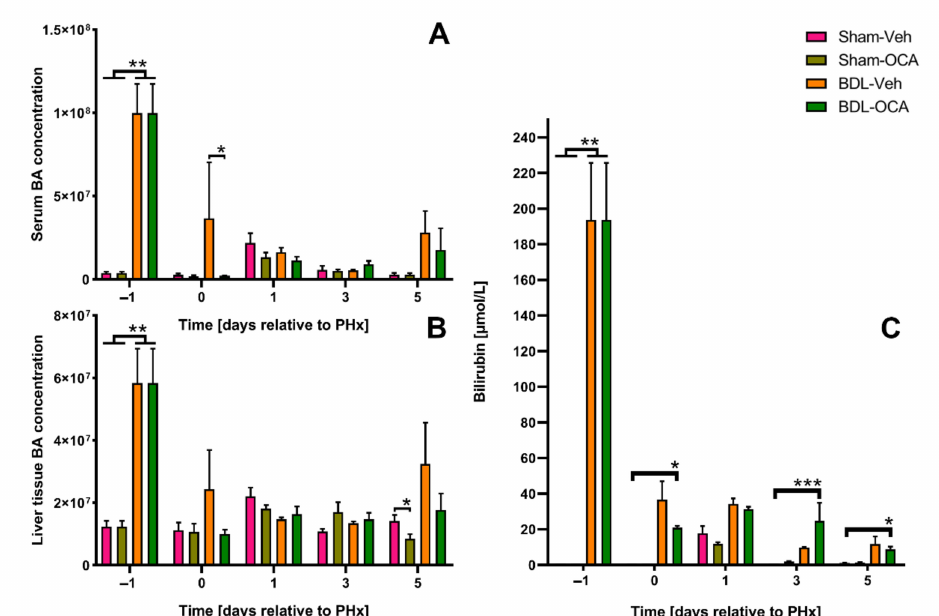
Figure 2. Obstructive cholestasis increases the total amount of serum and liver tissue bile acids (BAs) and bilirubin. Total amount of serum ( A ) and tissue BAs ( B ) and serum bilirubin levels ( C ) 1 day before PHx ( t = − 1 day), on the day of PHx ( t = 0 days), and on 1, 3, and 5 days after PHx. Data points are given as mean ± SEM. Significance was assessed using a Mann–Whitney U test. * indicates p ≤ 0.05; ** indicates p ≤ 0.01; *** indicates p ≤ 0.001. Veh, vehicle; BDL, bile duct ligation; OCA, obeticholic acid.